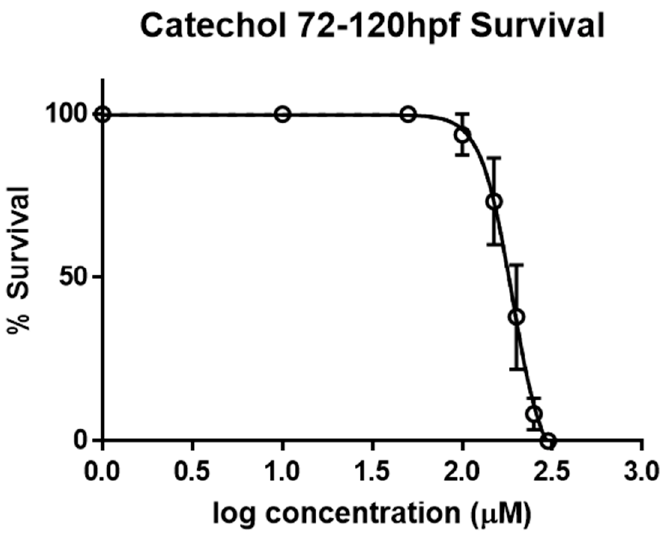
Figure 1. Determination of LC 50 values for catechol exposure against 72–120 hpf zebrafish larvae. In total, 72 hpf zebrafish embryos were exposed to catechol in HEPES buffered E3 (HE3) containing 0.5% DMSO for 48 h. Percent survival is calculated as 100-(number of dead embryos/number of total embryos × 100) and then plotted as four-parameter variable slope curve.